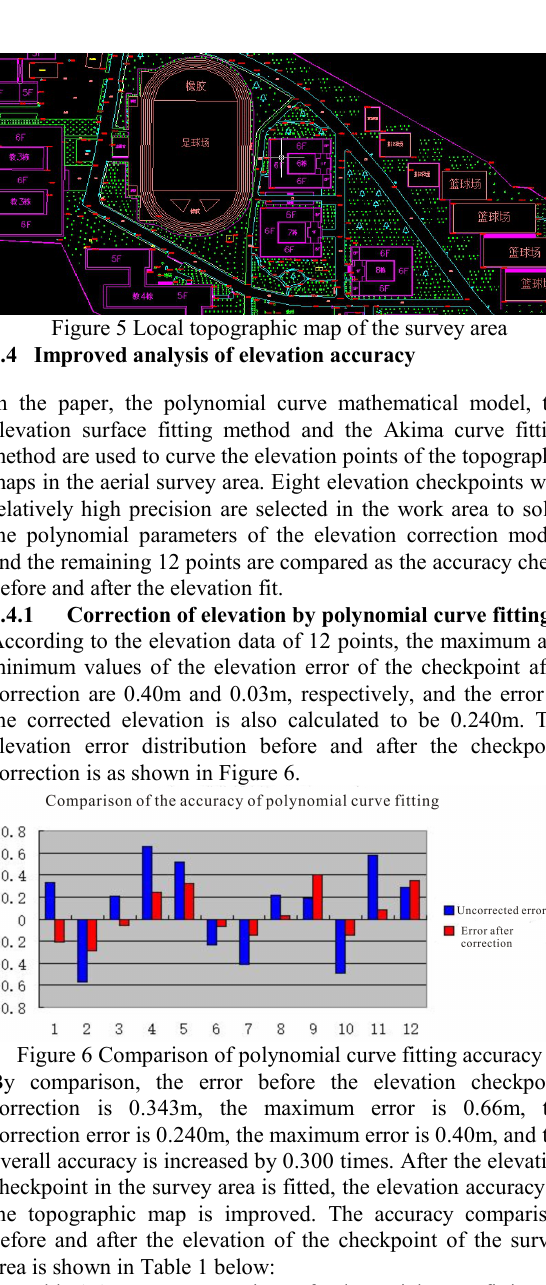
Table 1 Accuracy comparison of polynomial curve fitting